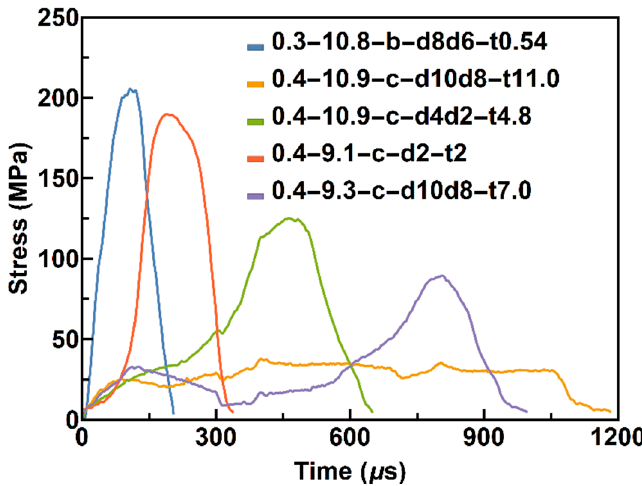
Figure 2. Incident waves using different pulse shapers.